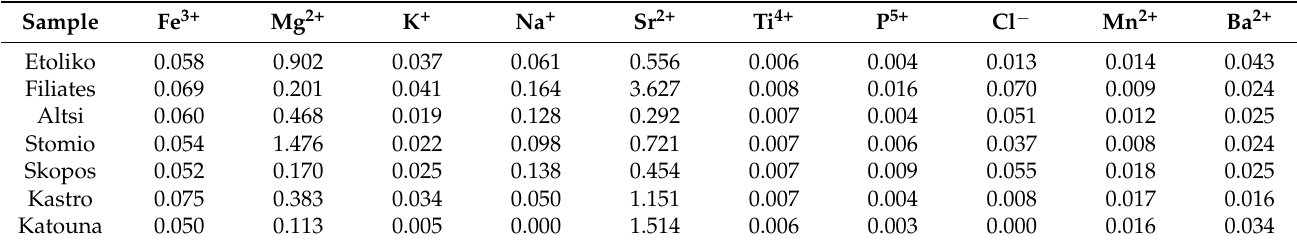
Table 1. Trace elements content (wt.%) of the studied gypsum-evaporite samples.